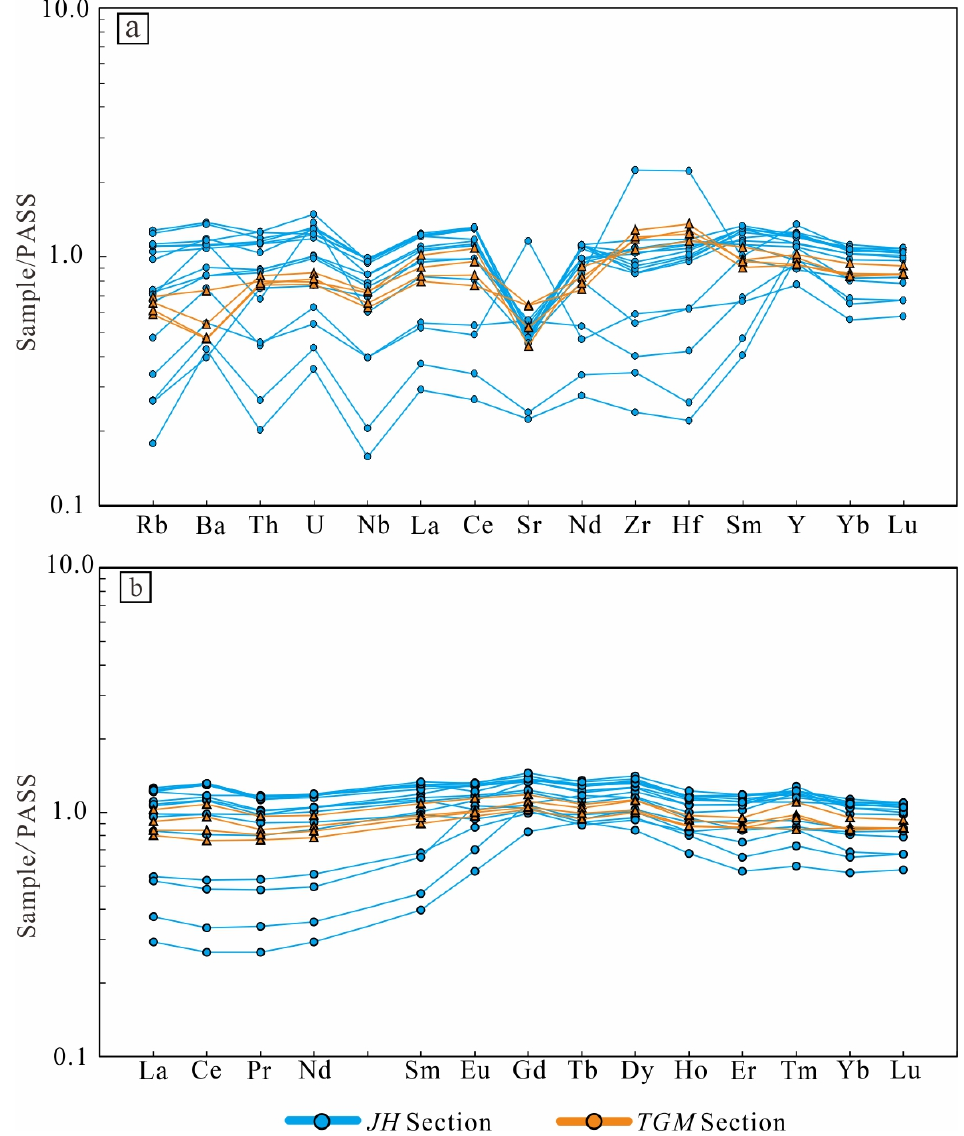
Figure 6. Characterization of trace elements and rare earth elements in the JH and TGM sections (PAAS data from [48]). ( a ) PAAS rock standardization chart of trace elements in the fine-grained sedimentary rocks of the Xu-3 Member; ( b ) PAAS standardization chart of REEs in the fine-grained sedimentary rocks of the Xu-3 Member.